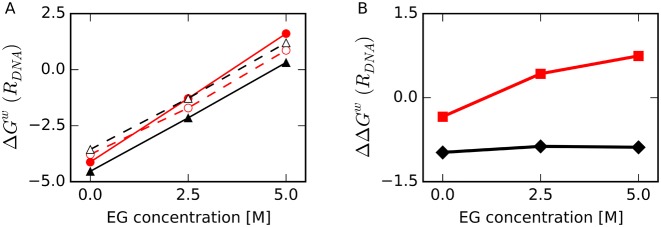
(A) Normalized average free energy of a water molecule relative to bulk water in the first hydration shell around DNA, ΔGw(RDNA), as a function of EG concentration for HP (filled red circles with solid line), TBA (filled black triangles with solid line), unHP (open red circles with dashed line) and unTBA (open black triangles with dashed line). (B) Difference in ΔGw(RDNA) between folded and unfolded structures, ΔΔGw(RDNA), for HP versus unHP (red squares) and TBA versus unTBA (black diamonds). All energies are shown in kcal/mol/water at 298 K.